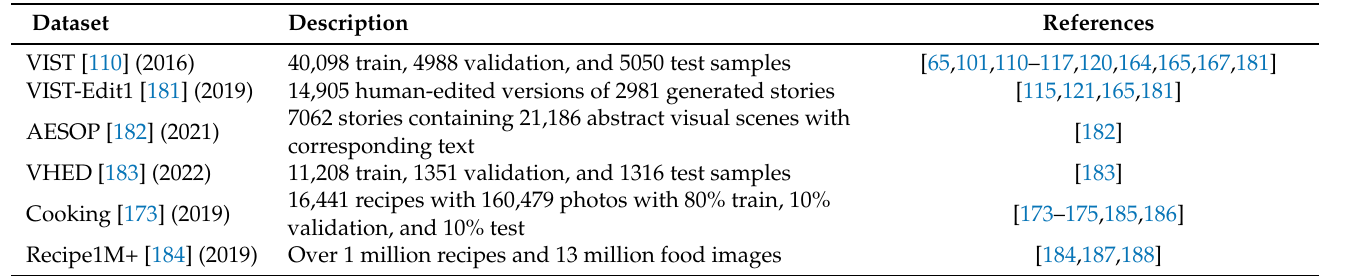
Table 6. An overview of the